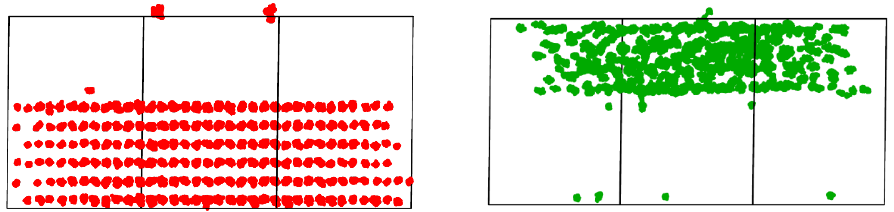
Figure 9. Indium (red) and zirconium (green) diffusion paths in defective ZrO 2 (102) over In 2 O 3 (111) physical mixture.